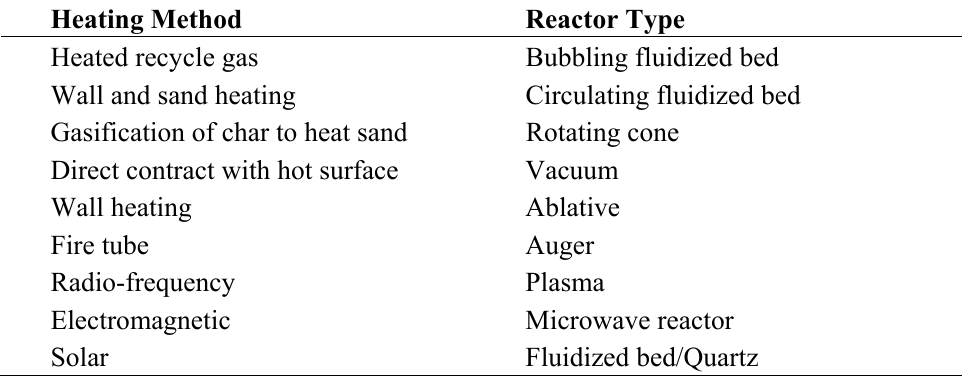
Table 5. Typical heating methods used in different reactors